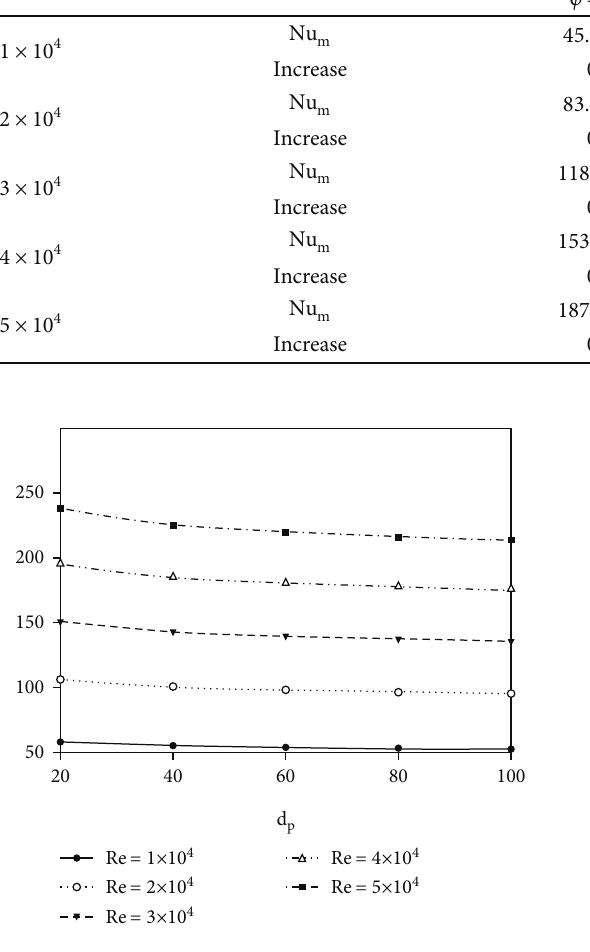
Figure 9: Changes in the average Nusselt number depending on the diameter of the nanoparticles, for di ff erent Reynolds ’ numbers.